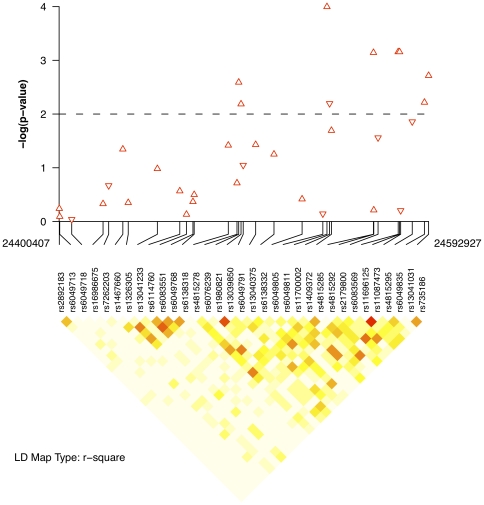
Association of C20orf39 SNPs with depressive symptoms of Scz.Magnitudes and directions of associations are displayed in the upper panel, with upwards-oriented triangles indicating a positive correlation with symptom factor score. A dashed line is provided at the inclusion threshold for the truncated product of P-values. Connecting lines relate the physical positions of associations to SNP labels in the corresponding LD-map (r
2). Plot generated using snp.plotter for R [66].